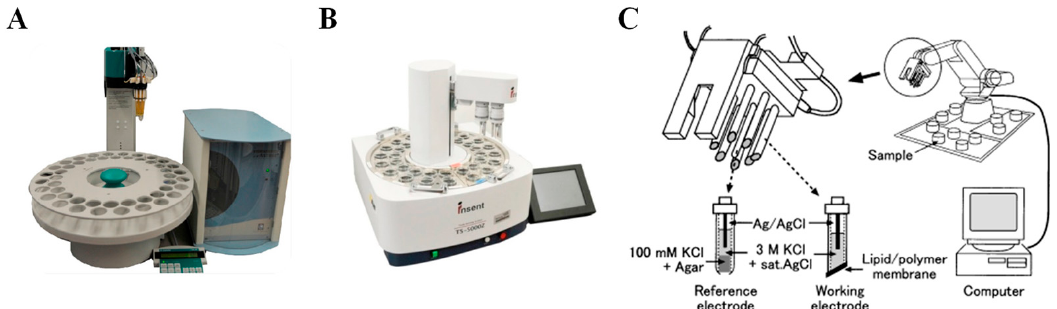
Figure 2. Commercially available E-tongues: ( A ) Alpha M.O.S E-tongue Astree II; ( B ) Insent E-tongue TS-5000Z; ( C ) Insent E-tongue SA402B. Reproduced from [55,57] with permission from Elsevier.